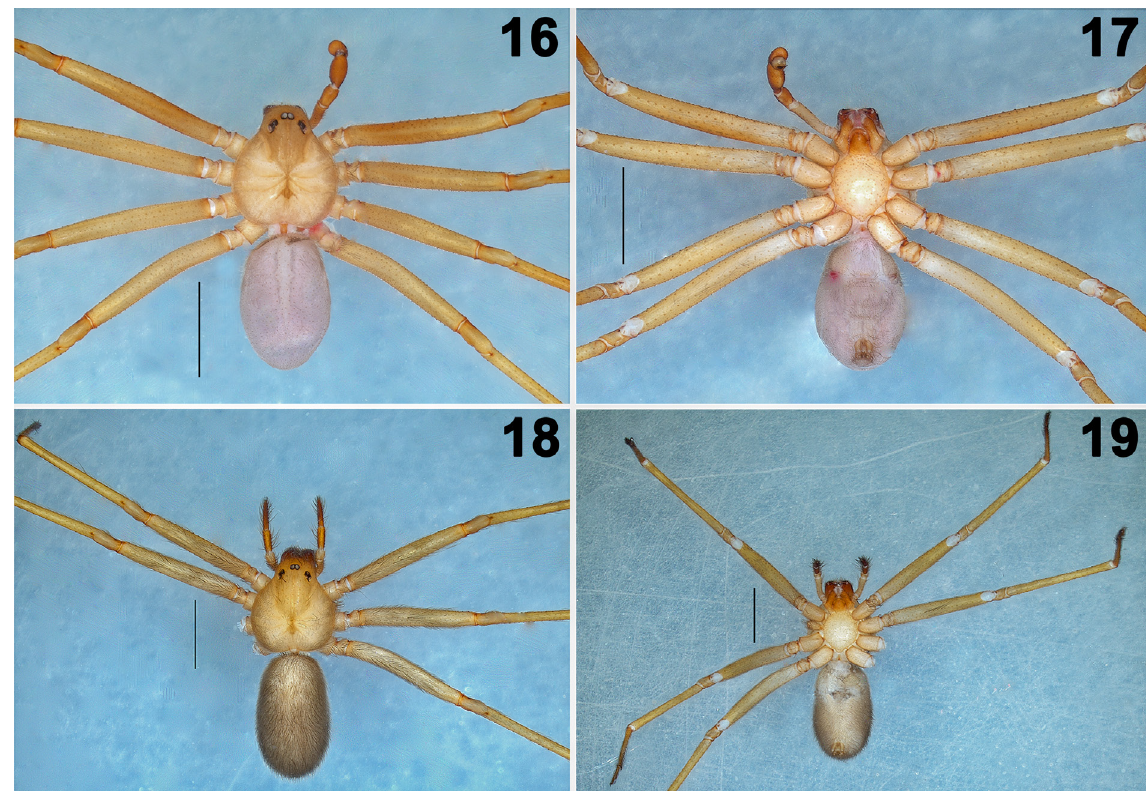
Figs 16–19. Loxosceles tolantongo sp. nov. 16–17 . Habitus of ♂ holotype (CNAN-T01317), dorsal and ventral views, respectively. 18–19 . Habitus of ♀ paratype (CNAN-T01321), dorsal and ventral views, respectively. Scale bars = 2